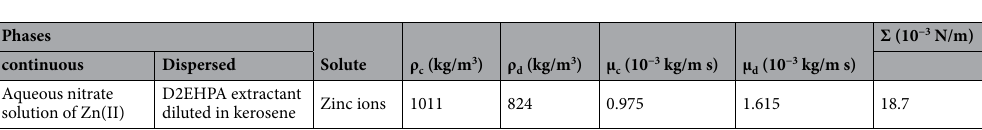
Table 2. Characteristics of chemical system used in the pilot-plant